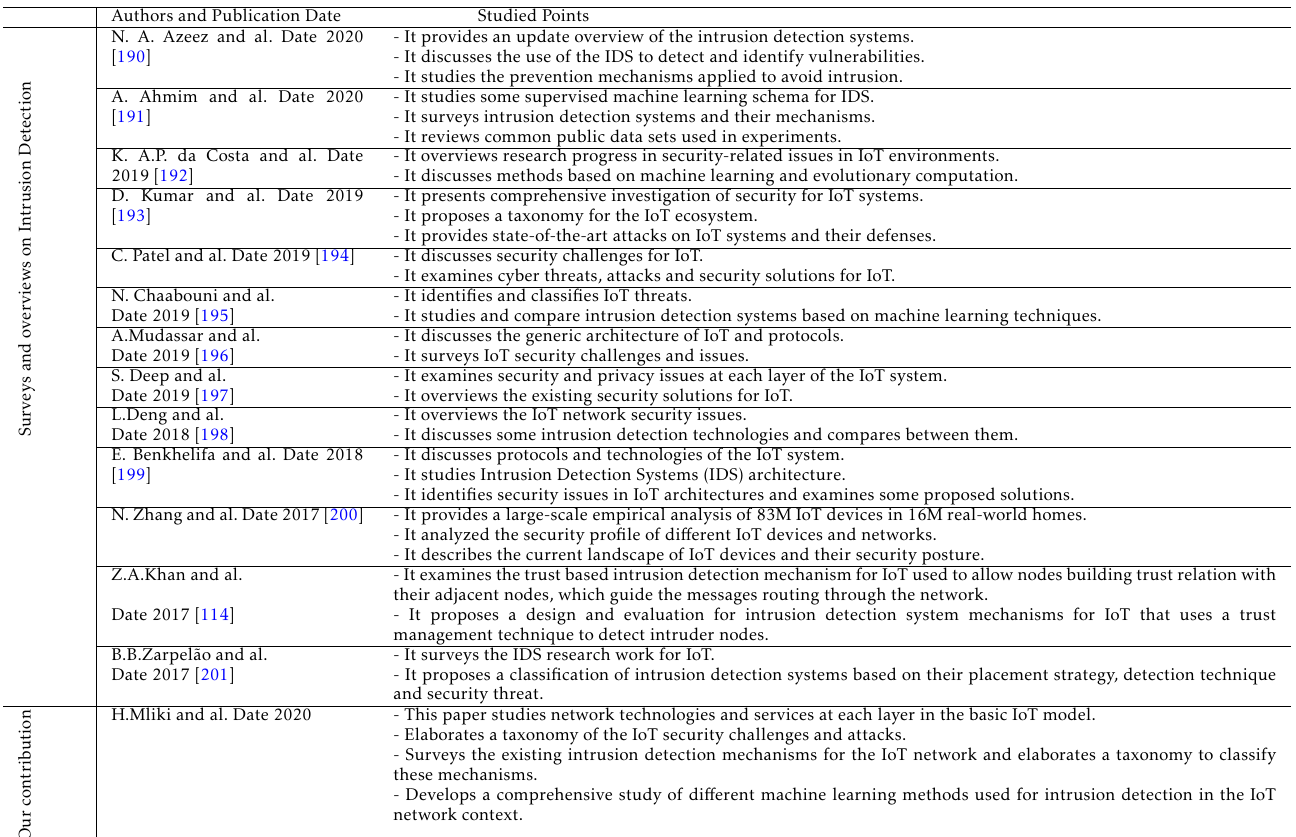
Table 3. Recent surveys on IoT